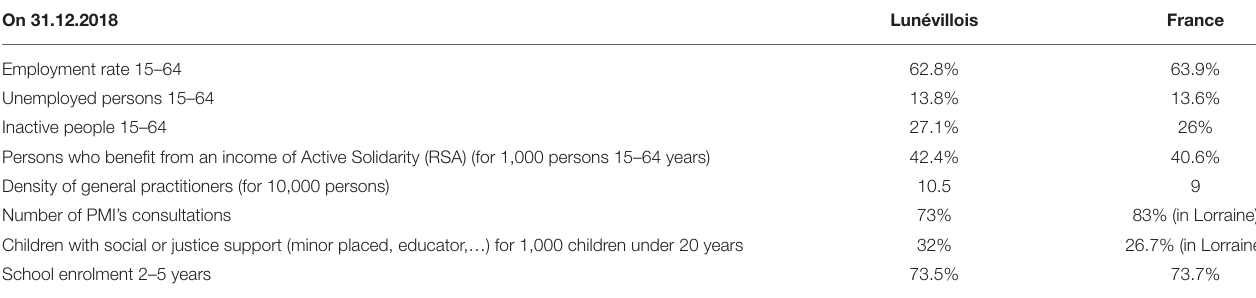
TABLE 2 | Context of the Lunevillois